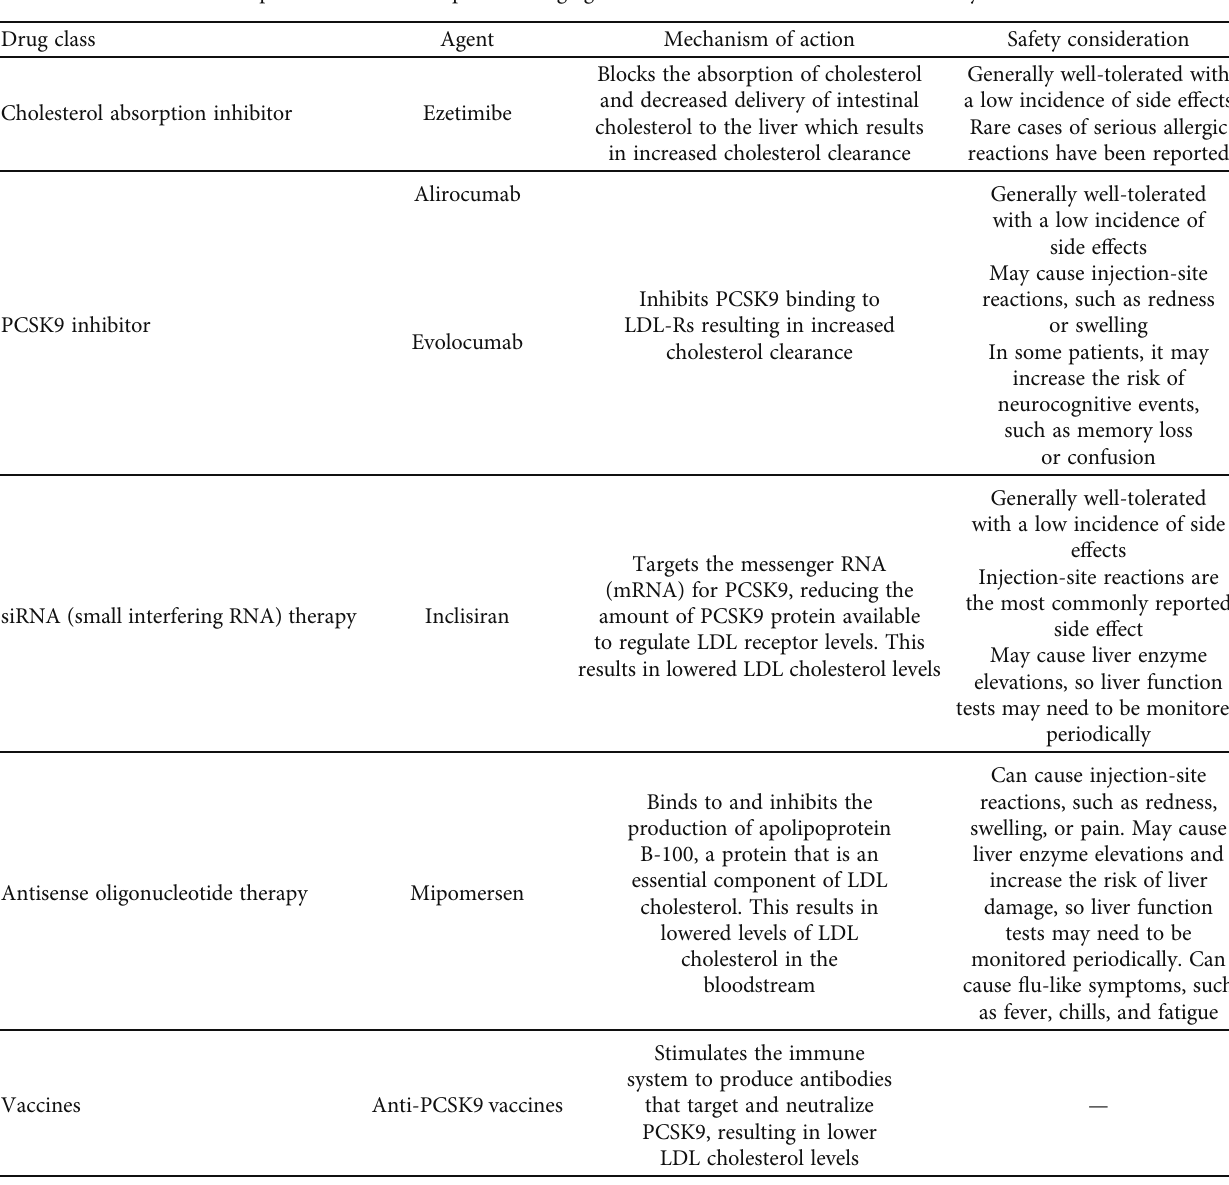
Table 1: Comparison of di ff erent lipid-lowering agents in terms of mode of action and safety